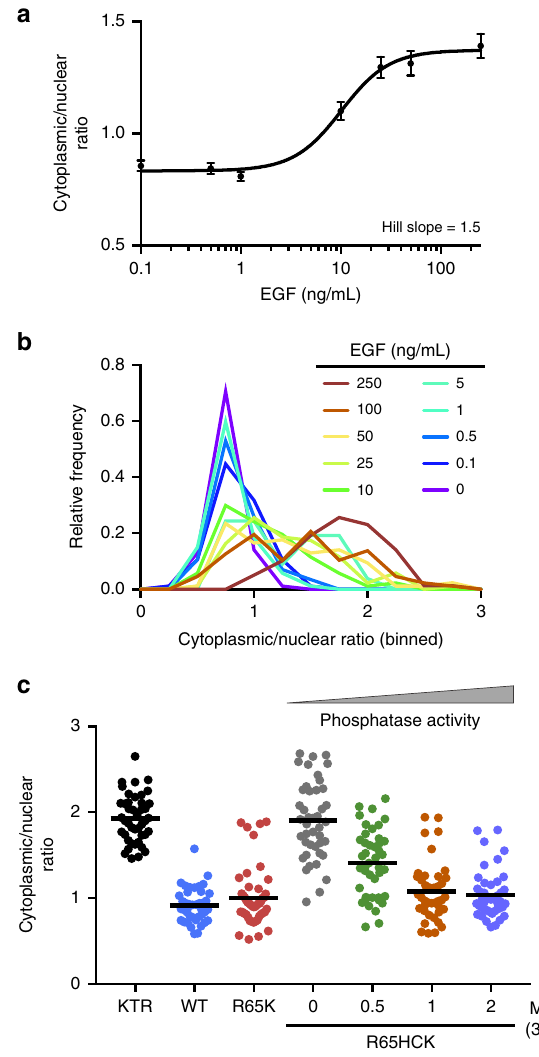
Fig. 6 Analysis of ERK activity in response to different doses of growth factor stimulation and optically tuned phosphatase function. a The cytoplasmic/nuclear ratios for the ERK-KTR-mCherry reporter in HEK293T cells were plotted for a range of EGF concentrations and fi tted with a Hill function. Based on the calculated Hill slope, a graded response is observed. Error bars represent the standard error of the mean of 85 – 90 cells per condition pooled from three biological replicates. b Histogram representation of the obtained data more clearly depicts the graded response as seen by a unimodal distribution. c Optical activation of KIM- caged MKP3 shows a graded response for the regulation of pERK translocation upon increased UV irradiation and cell surface stimulation with EGF (100 ng/mL), and thus increased levels of active MKP3. Each dot represents a single cell, black lines represent the mean, n = 40 – 45. Quanti fi ed cells were pooled from three biological replicates. One-way ANOVA tests showed p < 0.0001 comparing 0 min to 0.5 min irradiation, p = 0.0002 for 0.5 – 1 min irradiation, and p > 0.1 for 1 – 2 min irradiation, indicating a signi fi cant difference for the fi rst two comparisons and no signi fi cant difference for the third. Data are provided in the Source Data fi